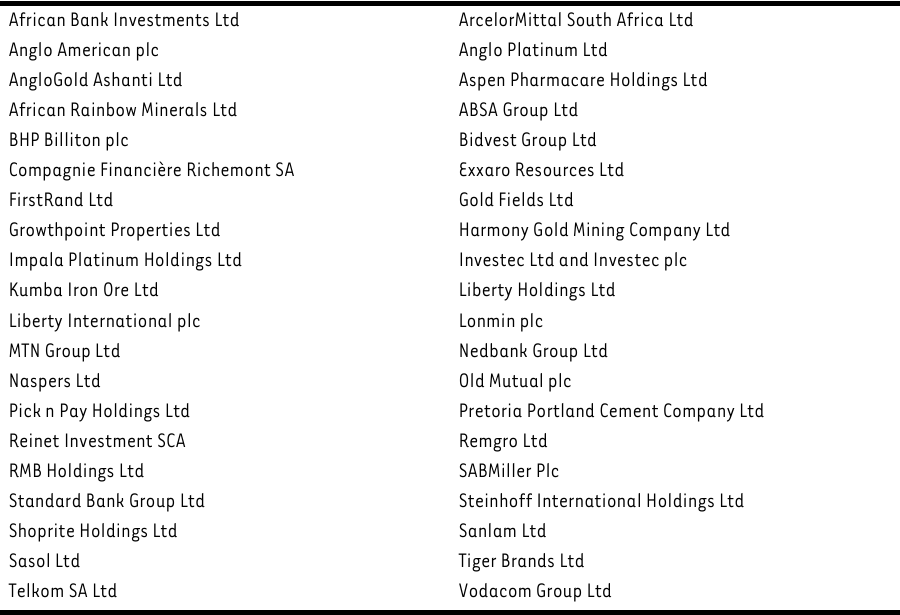
Companies included in the population